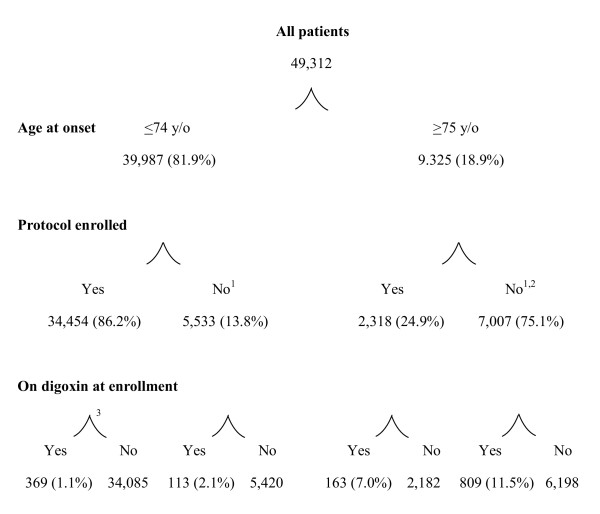
Women over 20 years old with breast cancer in Denmark, 1995 to 2008. 1Excluded from analysis of relapse because relapse data were not available; 2includes 26 patients (none on digoxin) who were assigned to protocol but who accrued no time on protocol treatment; 3main analysis file.